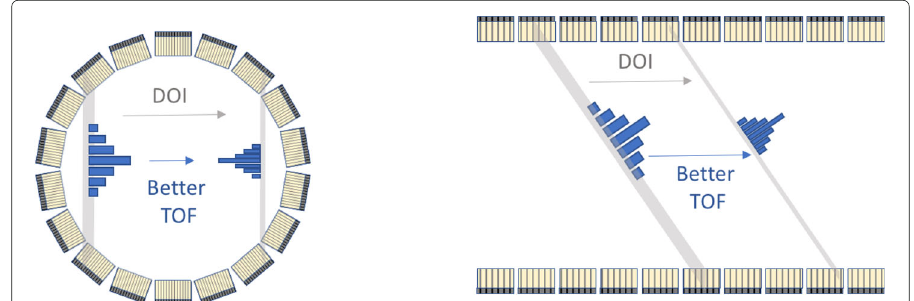
Fig. 16 Two possible improvements in future total body PET systems: introduction of DOI and better